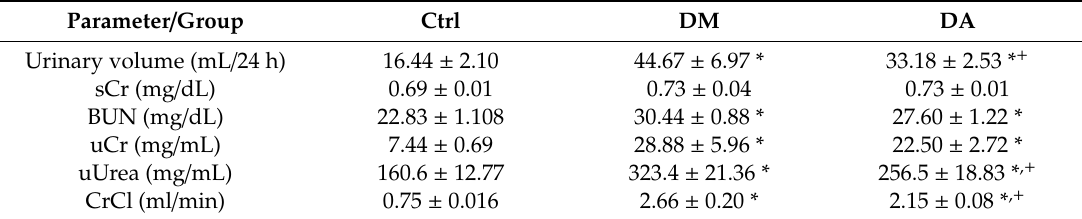
Table 1. Biochemical markers of renal